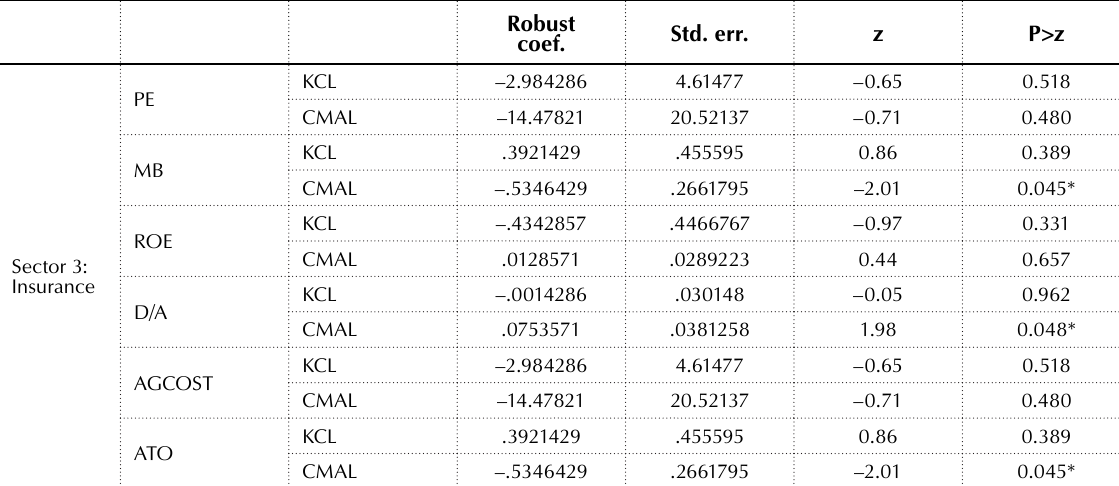
Table 9. GLS panel data regression for the insurance sector